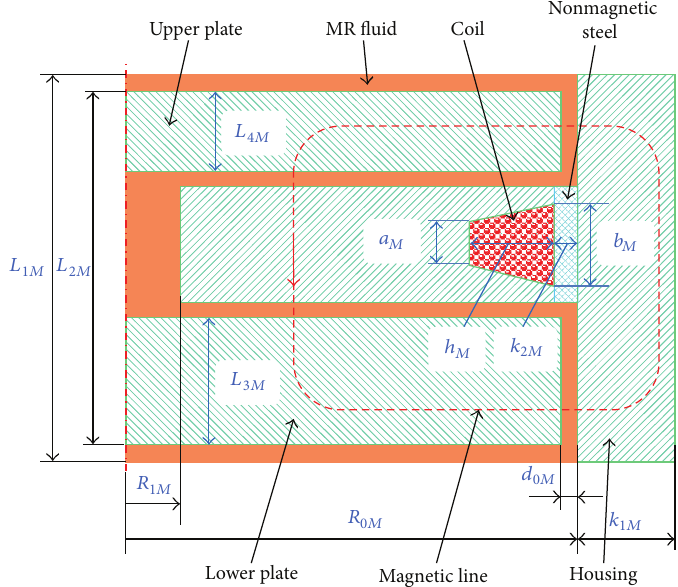
Figure 23: Section of MR valve for brake-mount